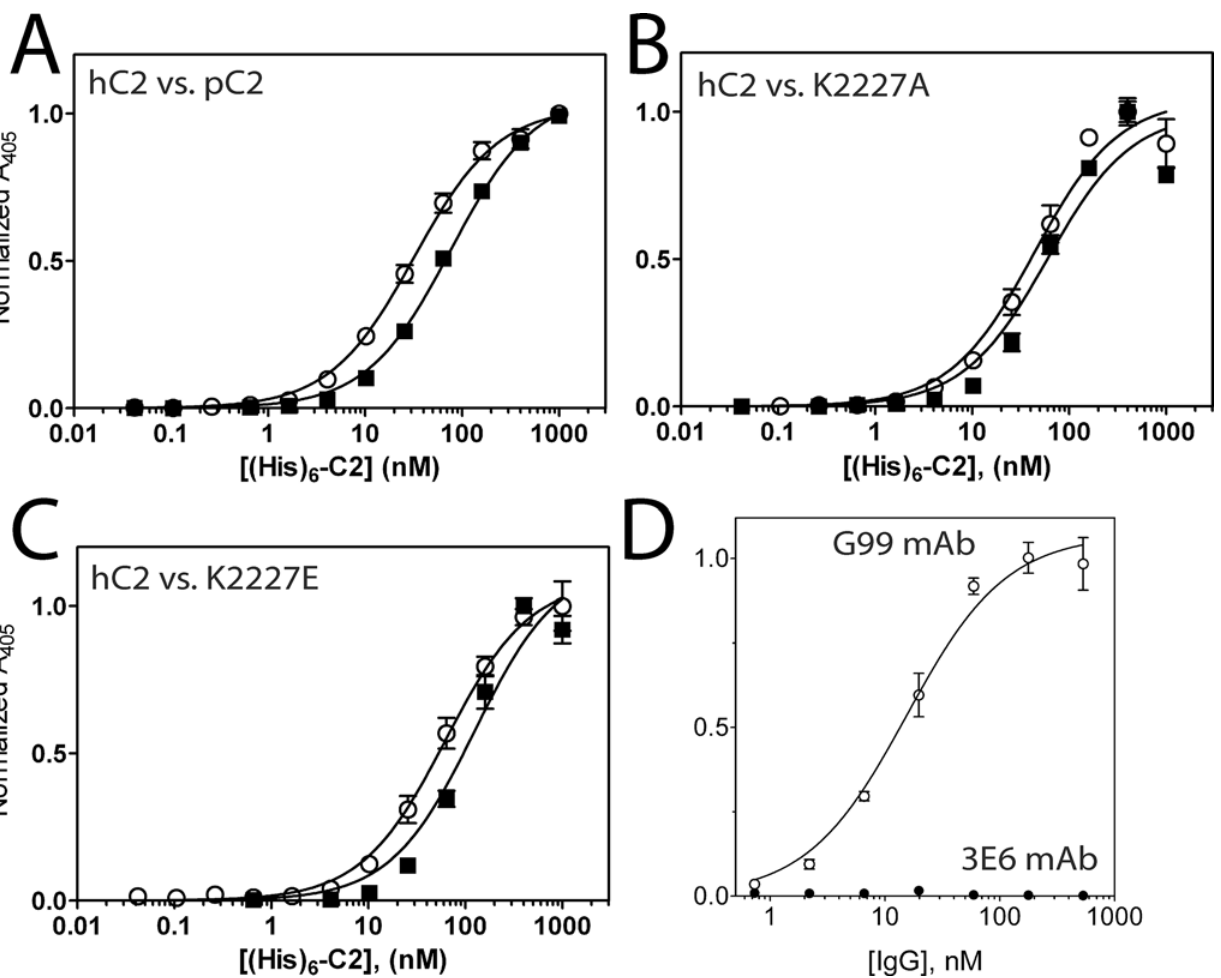
Fig 6. PS membrane and PS-bound fVIII C2 ELISA results for factor VIII C2 domain variants and inhibitory antibodies. (A) Comparison of human (open circles) and porcine (closed squares) factor VIII C2 domains binding to PS membrane surfaces. (B) Comparison of human factor VIII C2 domain (open circles) with the human K2227A C2 domain mutant (closed squares). (C) Comparison of human factor VIII C2 domain (open circles) with the human K2227E C2 domain mutant (closed squares). (D) Binding of G99 (open circles) and 3E6 (closed circles) to PS-bound fVIII C2 domain. Bound His 6 -C2 was detected with Ni-NTA-alkaline phosphatase, and bound IgG was detected with a AP-conjugated goat anti-mouse